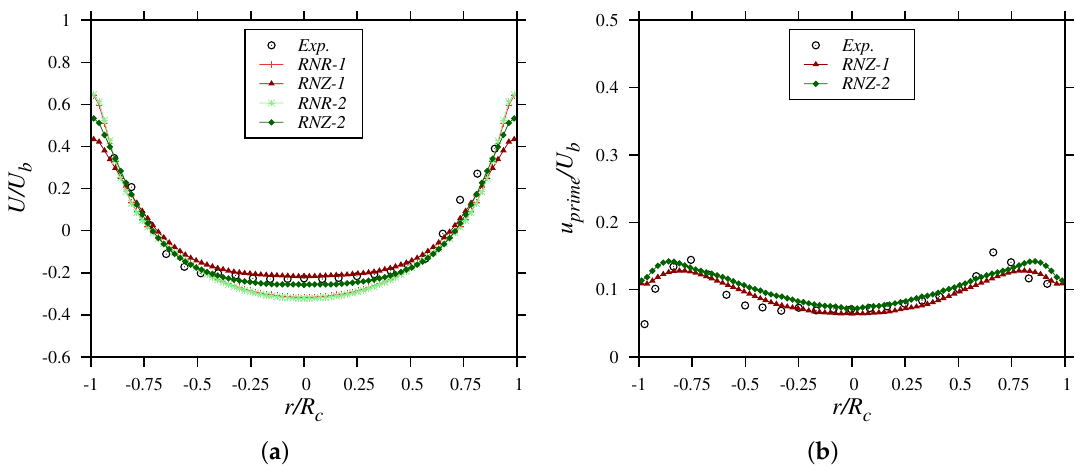
Figure 4. Mean and RMS profiles at x = 70 mm: ( a ) mean axial velocity; ( b ) RMS axial velocity